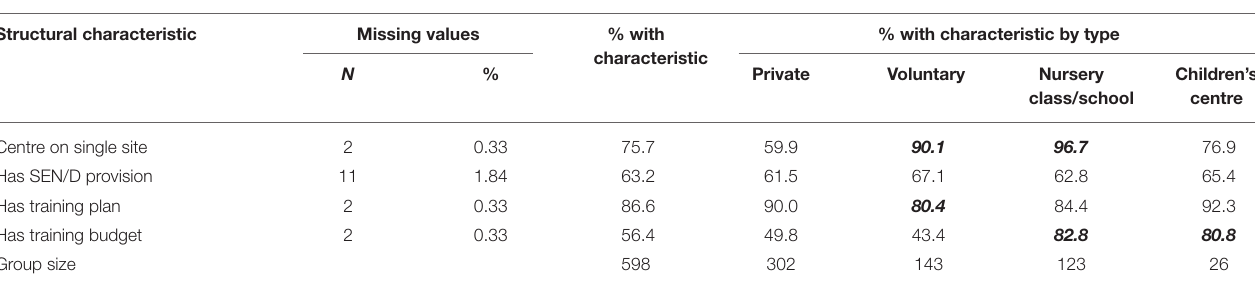
TABLE 2 | Summary of binary structural